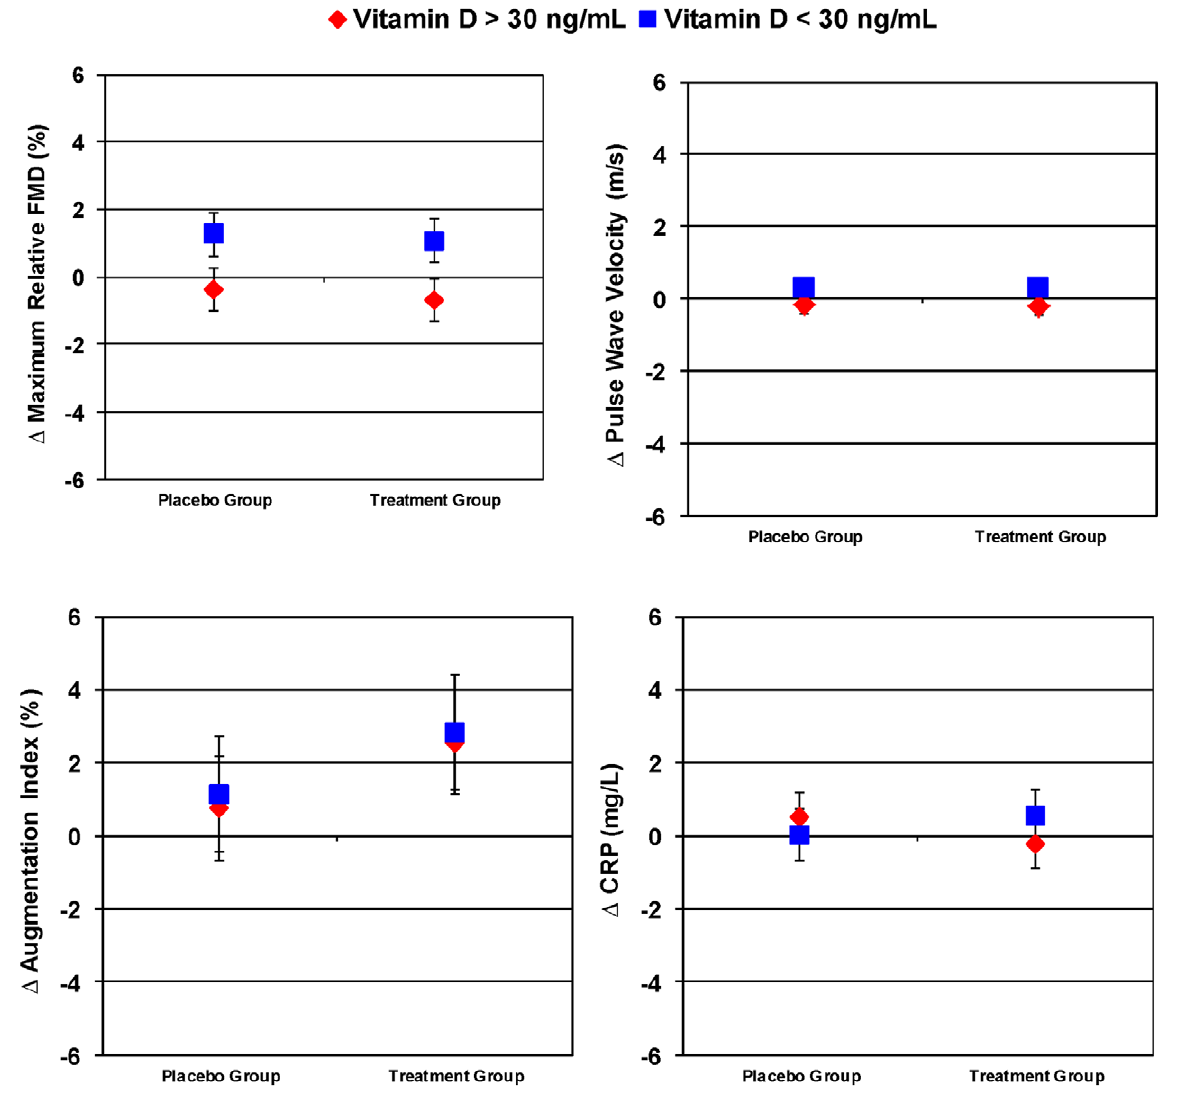
Figure 2. Interactions Between the Effects of Treatment Group and Baseline Vitamin D Status on Outcome Variables . Abbreviations as in Table 1.